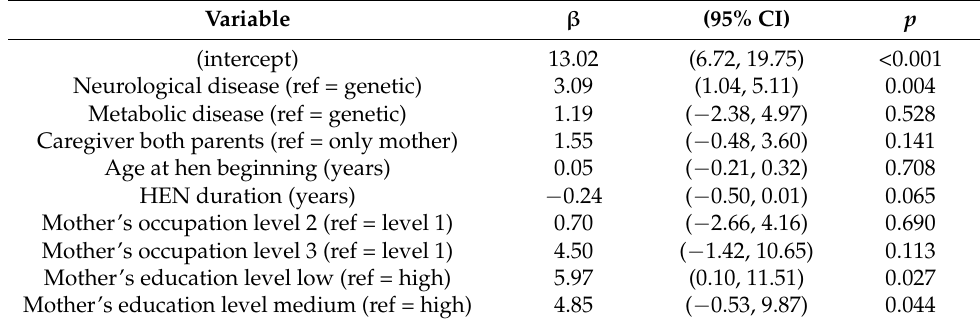
Table 3. Multiple Poisson regression model estimates for health-related quality of life score. Results for main analysis (mother as caregiver, alone or with